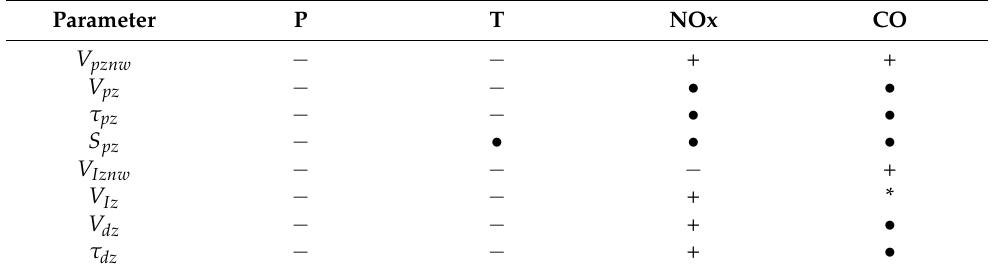
Table 7. Impact of reactor geometrical and mixing parameters on performance and emissions.